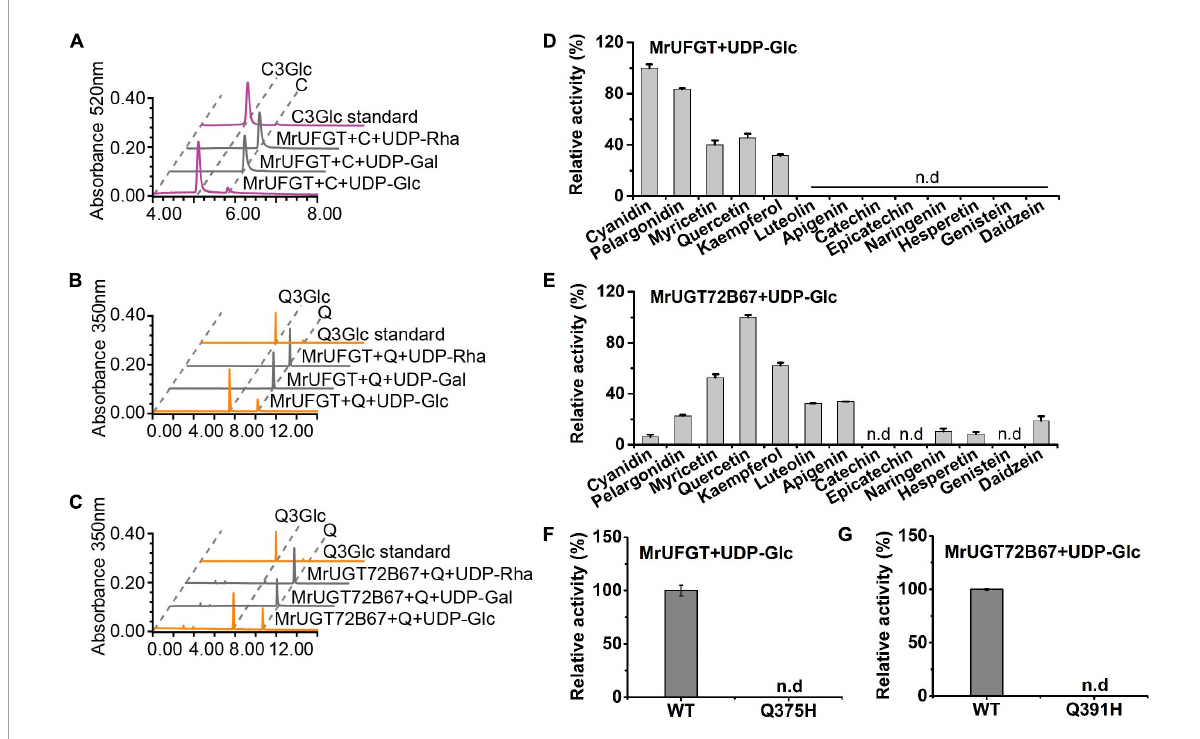
FIGURE7 Enzymatic assay of MrUFGT and MrUGT72B67. Enzyme activity analysis of recombinant MrUFGT with cyanidin (A) and quercetin (B) as sugar acceptors, UDP-glucoside (UDP-Glc), UDP-galactoside (UDP-Gal), and UDP-rhamnoside (UDP-Rha) as sugar donors. (C) Enzyme activity analysis of recombinant MrUGT72B67 with quercetin as sugar acceptor, UDP-Glc, UDP-Gal, and UDP-Rha as sugar donors. Relative activities of recombinant MrUFGT with UDP-Glc (D) and MrUGT72B67 with UDP-Glc (E) toward various flavonoids. Site-directed mutagenesis analysis of MrUFGT (F) and MrUGT72B67 (G) with quercetin as acceptor and UDP-Glc as sugar donor. Data are presented as mean ± SE ( n = 3). n.d, not